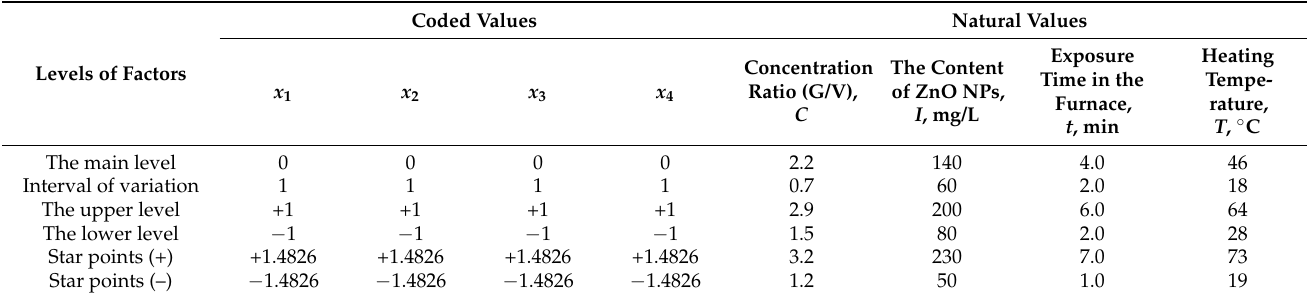
Table 1. Coding of factors and levels of their variation during